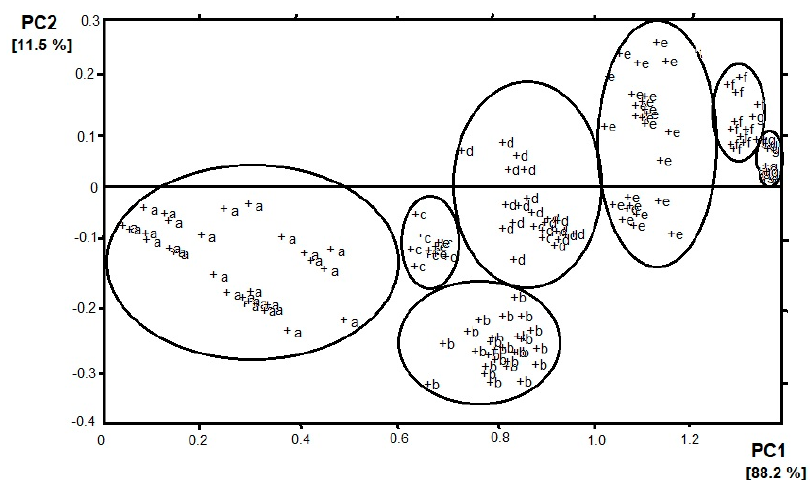
Figure 1. Result of principal component analysis (PCA) (PC1 vs. PC2) analysis of e-nose response on banana volatile compounds. Clusters were determined according to the increasing ripeness of the fruit (a–g).